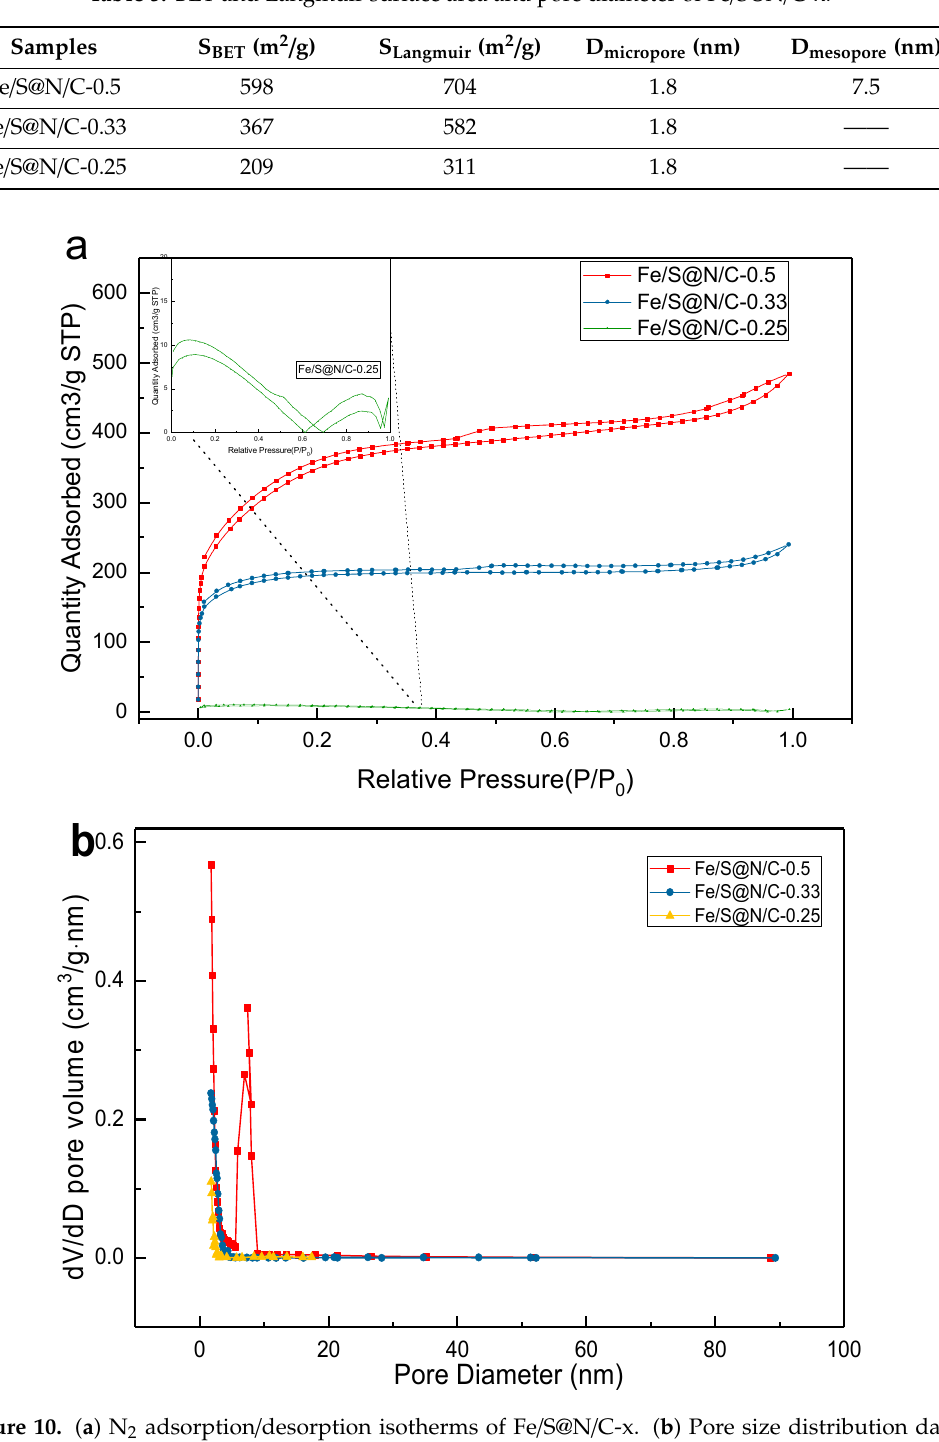
Figure 10. ( a ) N 2 adsorption/desorption isotherms of Fe/S@N/C-x. ( b ) Pore size distribution data obtained by the Barrett – Joyner – Halenda (BJH) method of Fe/S@N/C-x.